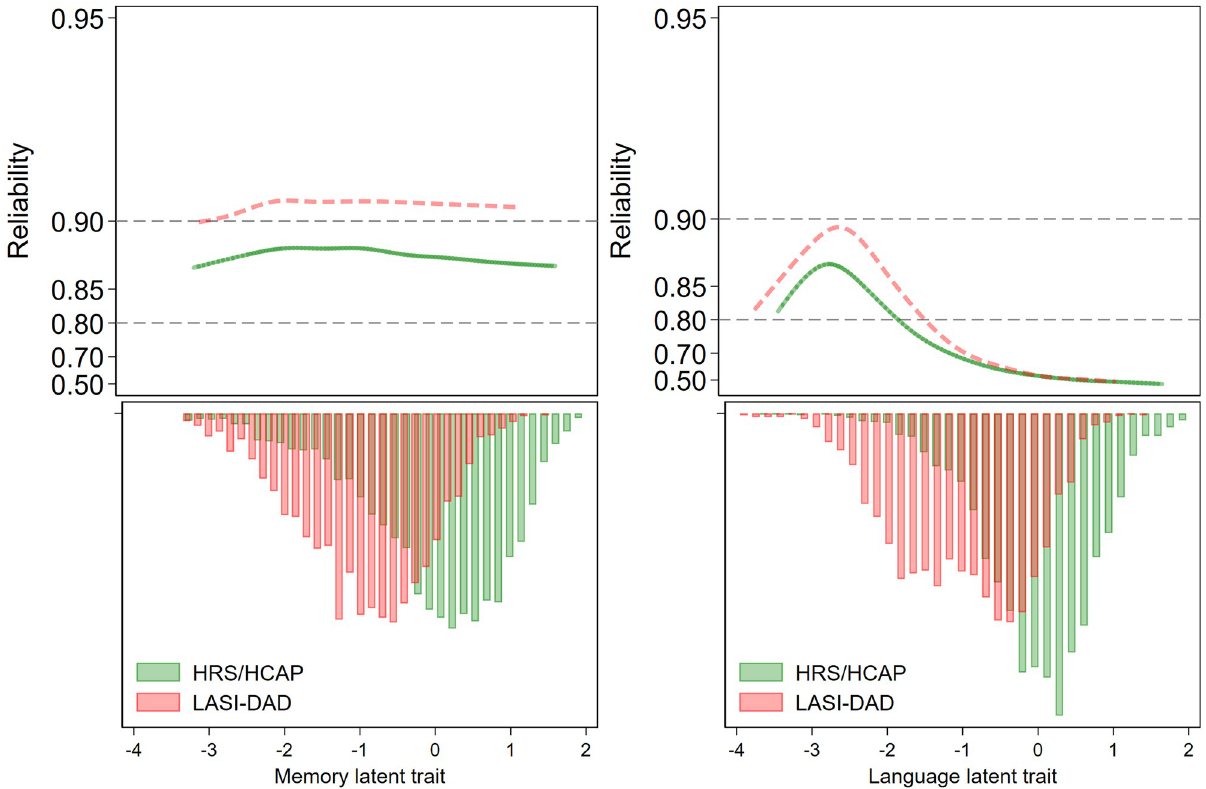
Fig 2. Information curves for the Differential Item Functioning (DIF)-modified episodic memory and language factors (reliability = 1–1/ information) (upper panel). The histograms are the population distribution on the latent trait (lower panel). With mostly continuous factor indicators for the episodic memory latent trait, reliability is constant over the range of theta (ability). With mostly categorical indicators for the language latent trait, reliability varies over the range of theta, as shown by a peak where most of the item difficulty parameters